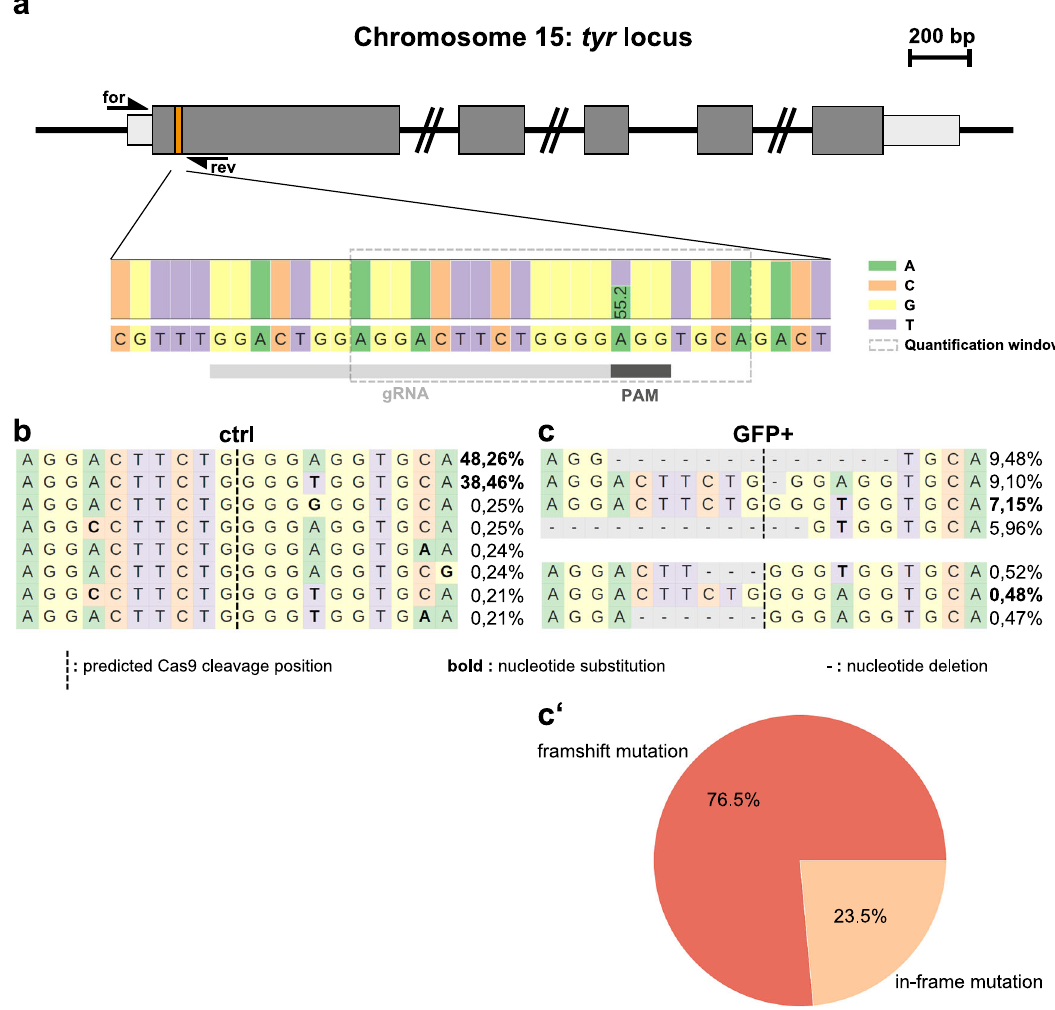
Fig. 3 Sequencing con fi rms high mutagenesis rates following Cas9-GFP expression. a Scheme of the tyr locus at chromosome 15. Exon sequences with translated and untranslated regions are represented in dark and light gray, respectively. Position of the CRISPR/Cas9 target in the fi rst exon is indicated with an orange box. Forward and reverse primers used for ampli fi cation of the target site (for and rev) are shown as half arrows. Scale bar: 200 base pairs (bp). Next generation sequencing of FAC-sorted cells from pooled embryos (see Supplementary Fig. 1a) revealed a single-nucleotide polymorphism at the fi rst position of the protospacer adjacent motif (PAM) indicated with a dark gray box downstream to the target site (gRNA) indicated by a light gray box. b , c Distribution of identi fi ed alleles around the cleavage site for the guide GGACTGGAGGACTTCTGGGG in control (ctrl) and GFP-positive cells (GFP + ). Nucleotides are indicated by unique colors (A = green; C = red; G = yellow; T = purple). Substitutions are shown in bold font. Horizontal dashed lines indicate deleted sequences. The vertical dashed line indicates the predicted cleavage site. Sequencing of controls ( b ) shows presence of the parental strands with a frequency of 48.26 and 38.46% which drops to 7.15 and 0.48% in GFP-positive cells ( c ). c ′ Further sequence analysis of GFP-positive cells shows that 76.5 and 23.5% of the introduced indels represent frameshift and in-frame mutations,